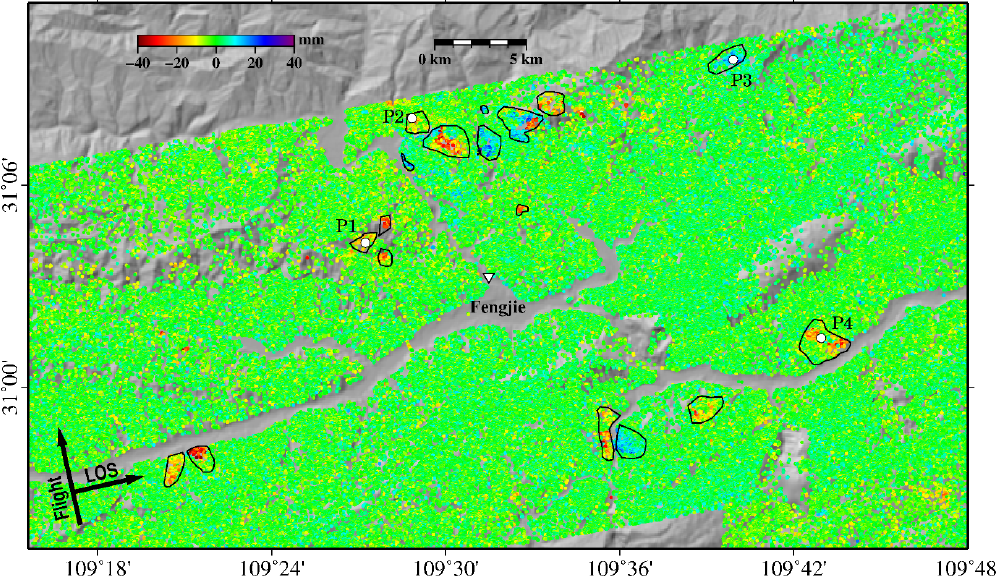
Figure 5. Mean displacement rate map measured at Fengjie. P1, P2, P3, P4 are points used for time series analysis shown in later sections.